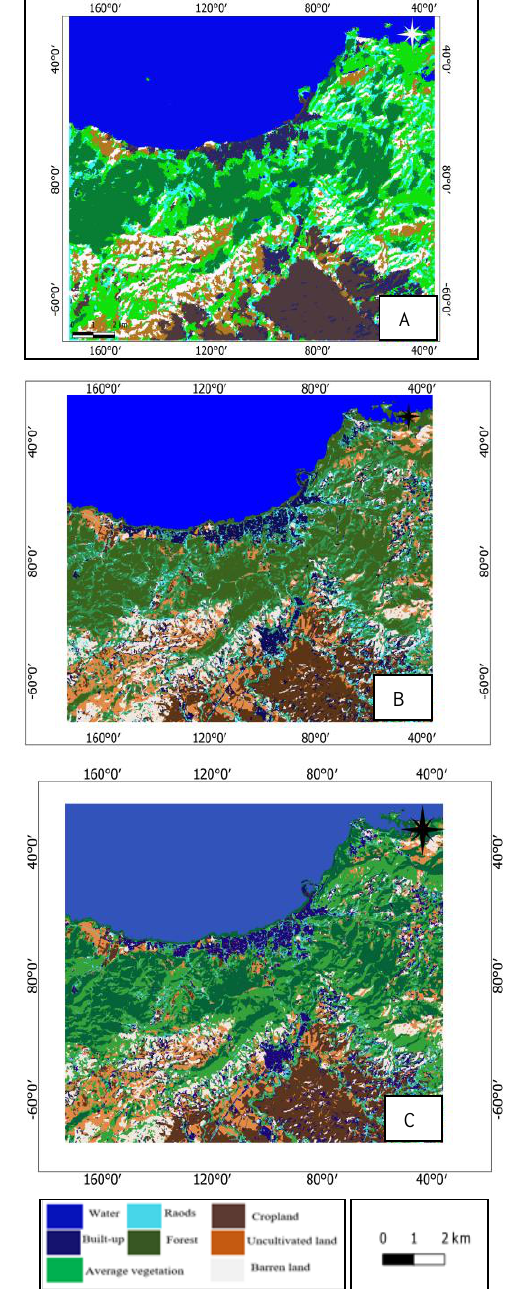
Figure 5 : Classification results: A: Proposed approach: CNN- OBIA, B: OBIA SVM , C: and OBIA